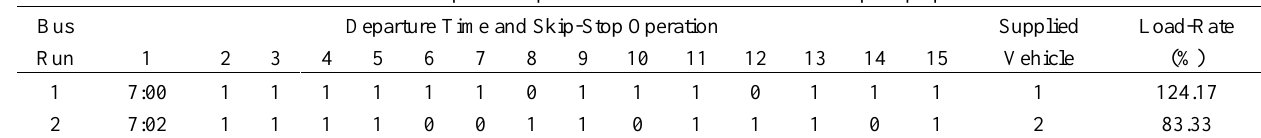
Fig. 6. The variation curve on the objective with iterations Table 3. The optimal departure times at the terminal and skip-stop